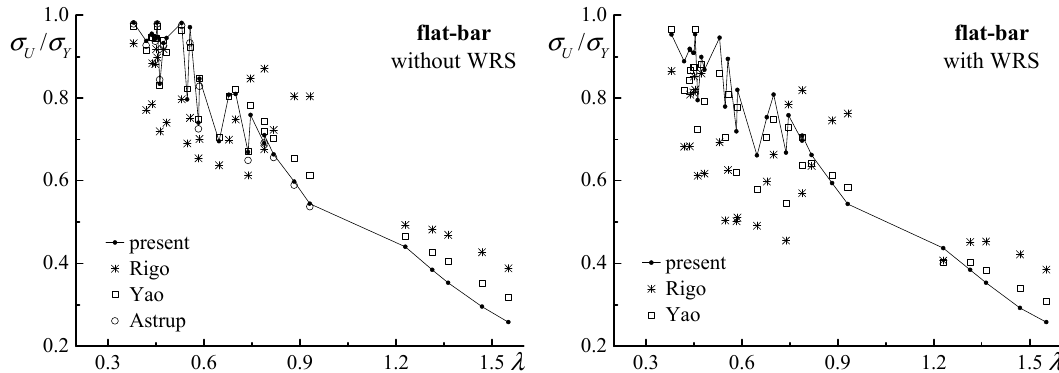
Figure 5. Results for the ultimate strength of flat-bat stiffened plate versus column slenderness ratio compared with the ISSC’2000 Report [11].